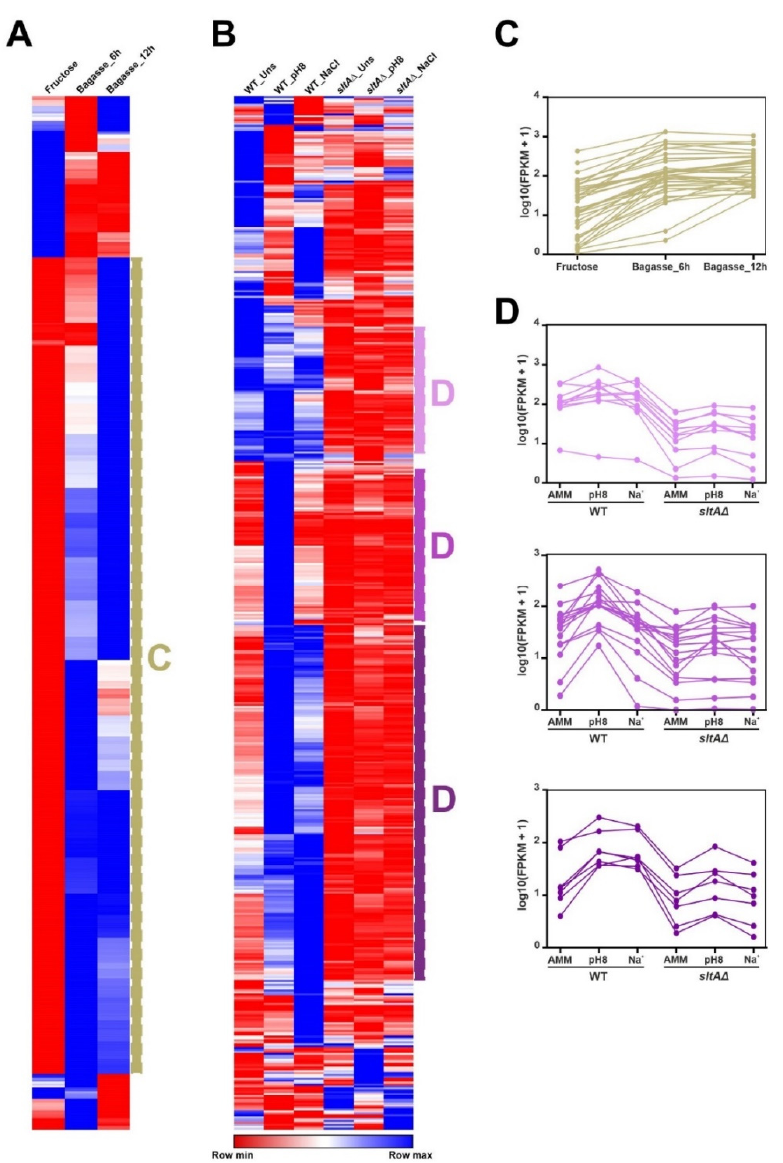
Figure 4. General modification of the expression pattern of TF-coding genes in response to specific culture conditions or in specific mutant backgrounds. Clustered heatmaps (Pearson correlation) showing a general, qualitative change in the expression levels of a majority of TF-coding genes in response to ( A ) the addition of sugarcane bagasse as the main nutrient source, or ( B ) deletion of sltA . Panels C and D show expression profiles of specific genes, selected from the groups highlighted in panels A and B , respectively. ( C ) Upregulation in a medium containing sugarcane bagasse. ( D ) Downregulation in a null sltA background in the three conditions tested (standard minimal medium or unstressed , alkalinity and sodium stress; upper graph), downregulation only at pH 8 (middle) or downregulation both at pH 8 and sodium stress